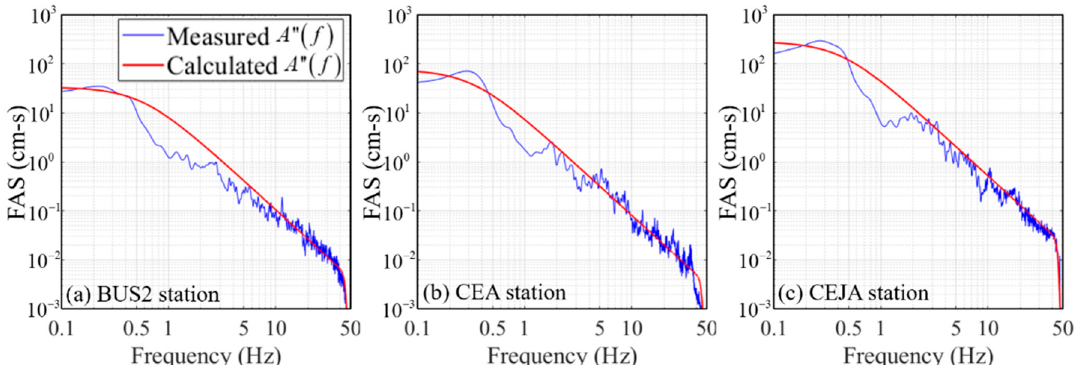
Figure 9. Measured and calculated Fourier amplitude spectrum (FAS) at three sample stations: ( a ) BUS2 station, ( b ) CEA station, ( c ) CEJA station.